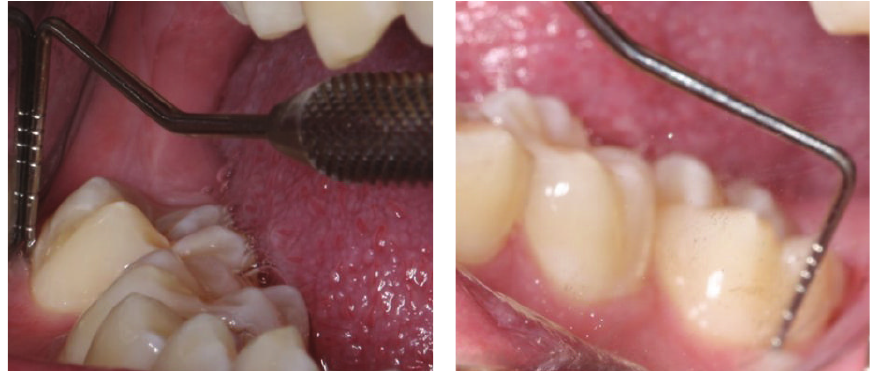
Figure 7: Postoperative clinical photograph of the lower right second molar confirming the pocket depth after the successful